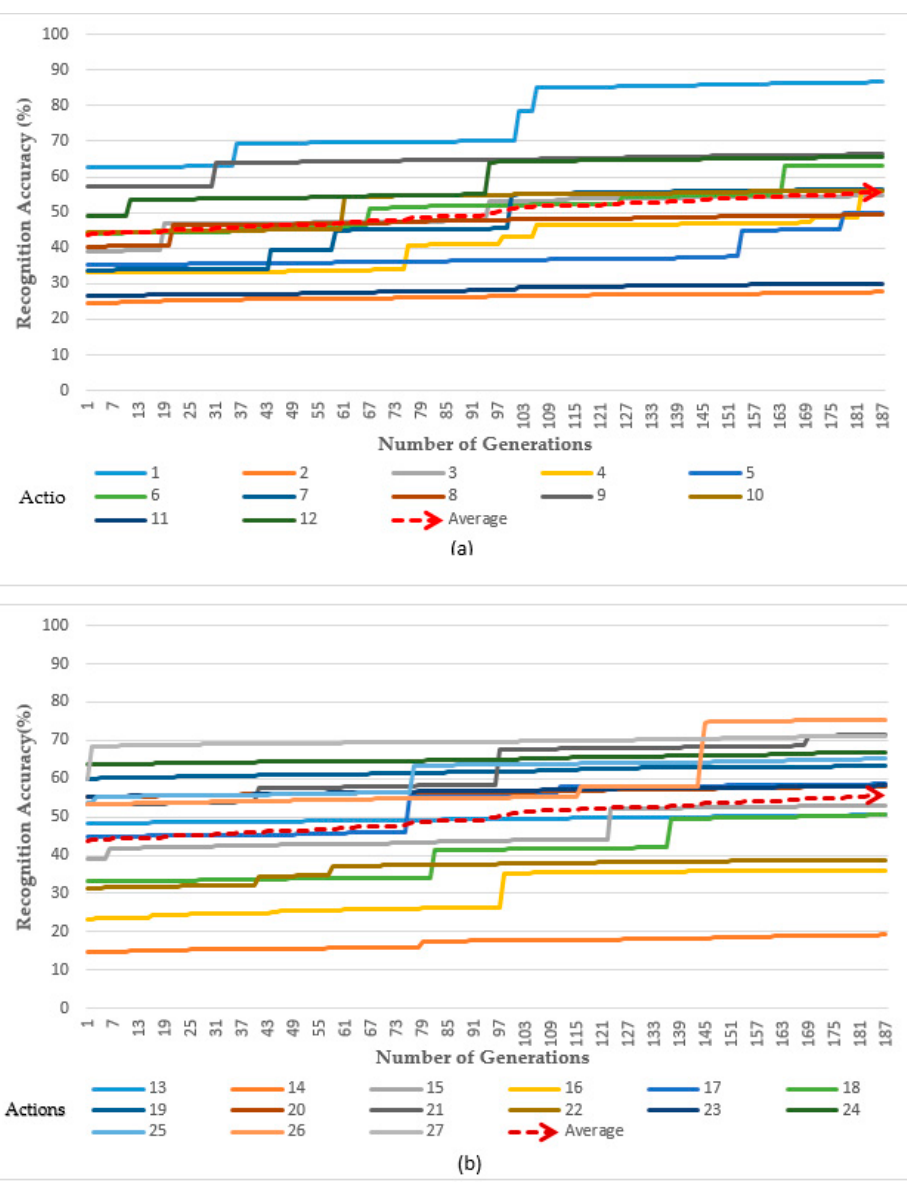
Figure 3. Accuracy with adjusted weights by Differential Evolution ( α = 1). (a) The first 13 actions Figure 9. Accuracy with adjusted weights by Differential Evolution ( α = 1). ( a ) The first 13 actions of of the datasets (1 to 13), (b) the last 14 actions of the datasets (14 to 27). the datasets (1 to 13), ( b ) the last 14 actions of the datasets (14 to